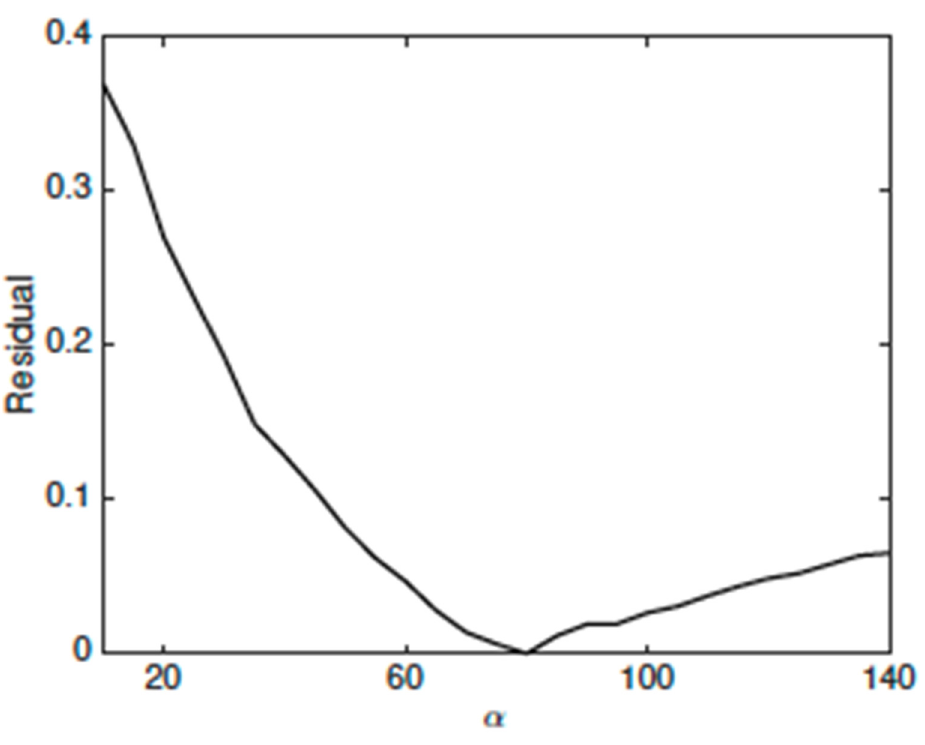
Figure 9. Exemplary case of application: EDOF IOL.